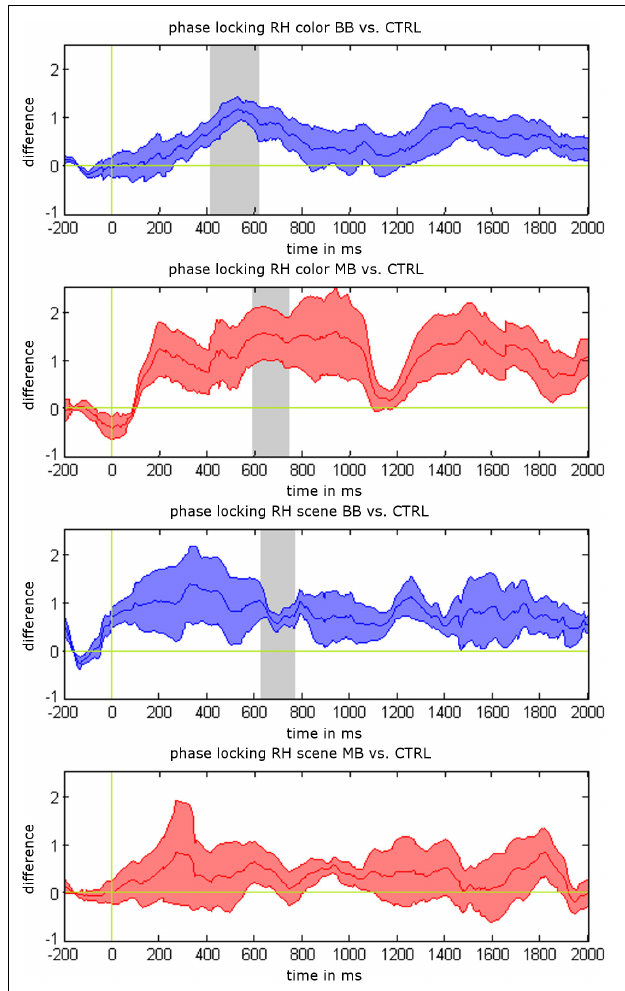
FIGURE 3 | Phase locking results for 5 Hz beat stimulation vs. control condition. Mean phase locking differences in the rhinal cortex are shown for binaural beats (BB) vs. control (CTRL) and monaural beats (MB) vs. control condition. All responses are averaged across patients. Shaded areas indicate standard error of the mean (S.E.M.). Gray areas show significant time intervals in a label-shuffled cluster statistic for stimulation vs. control in each condition ( p <